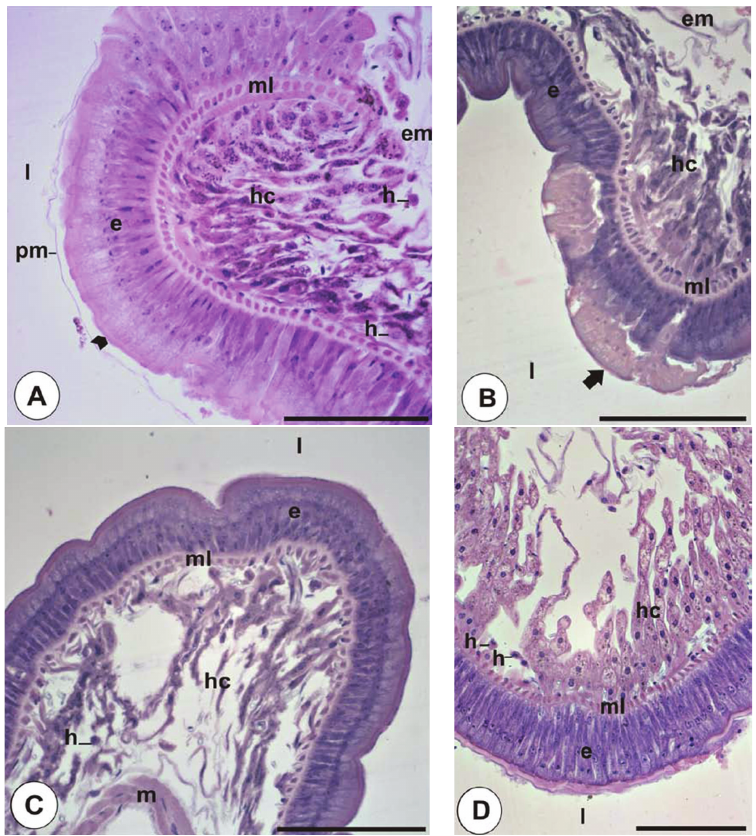
Figure 1: Micrographs of the R. padbergi midgut stained with HE. (A) Animals exposed for 7 days to the control soil; (B, C) animals exposed for 7 days to soil + biosolid; (D) animals exposed for 30 days to soil + biosolid. e: epithelium; em: external membrane; h: hemocyte; hc: hepatic cells; l: lumen; m: muscle fibers; ml: muscular layer; pm: peritrophic membrane; arrow head in (A) brush border; arrow in (B) epithelium renewal. Scale bars = 100 µ m.